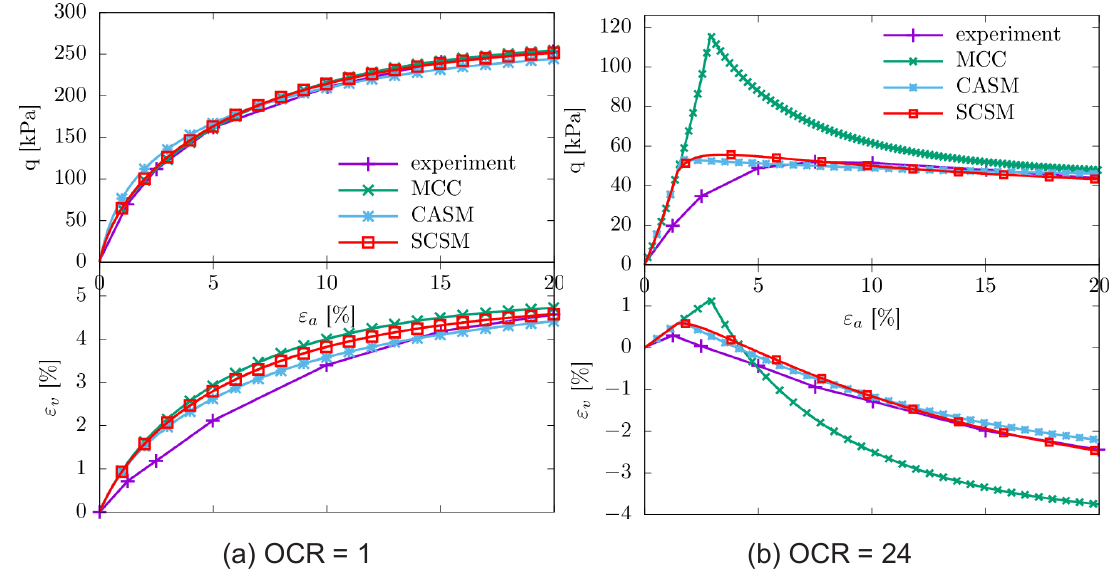
Figure 6: Simulation of drained compression of Weald clay for normally consolidated and overconsolidated states